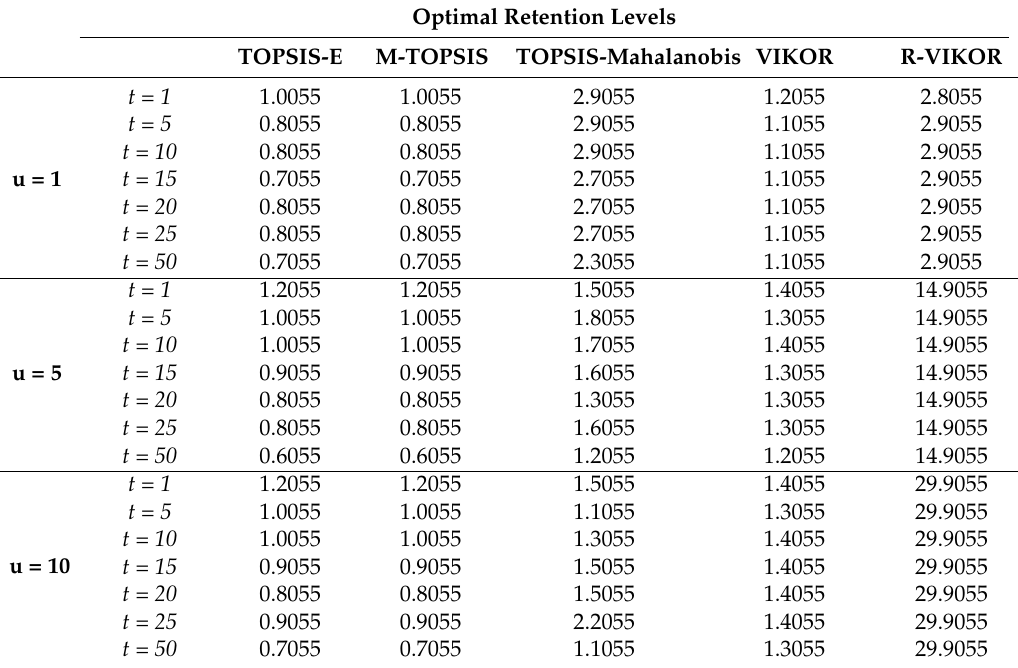
Table 6. Optimal retention level under the standard deviation premium principle.